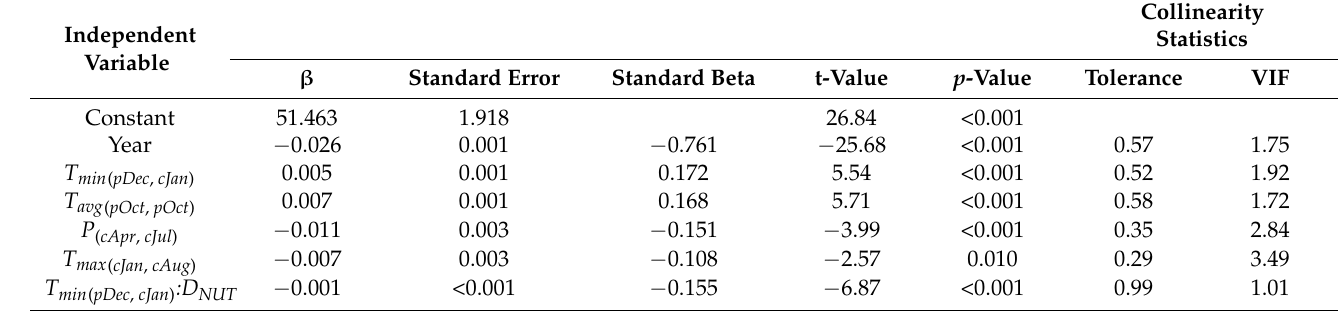
Table 1. The estimated statistical relationship between the annual radial growth rate of three red oak species and climate and other variables. (Year—the number of years since the trees were planted; T min ( pDec , cJan ) —the minimum temperature between December of the previous year and January of the current year; T avg ( pOct , pOct ) —the average temperature in October of the previous year; P ( cApr , cJul ) —the total precipitation between April and July of the current year; T max ( cJan , cAug ) —the maximum temperature between January and August of the current year; T min ( pDec , cJan ) : D NUT —the interaction term between the minimum temperature from December of the previous year to January of the current year and the dummy variable indicating Nuttall